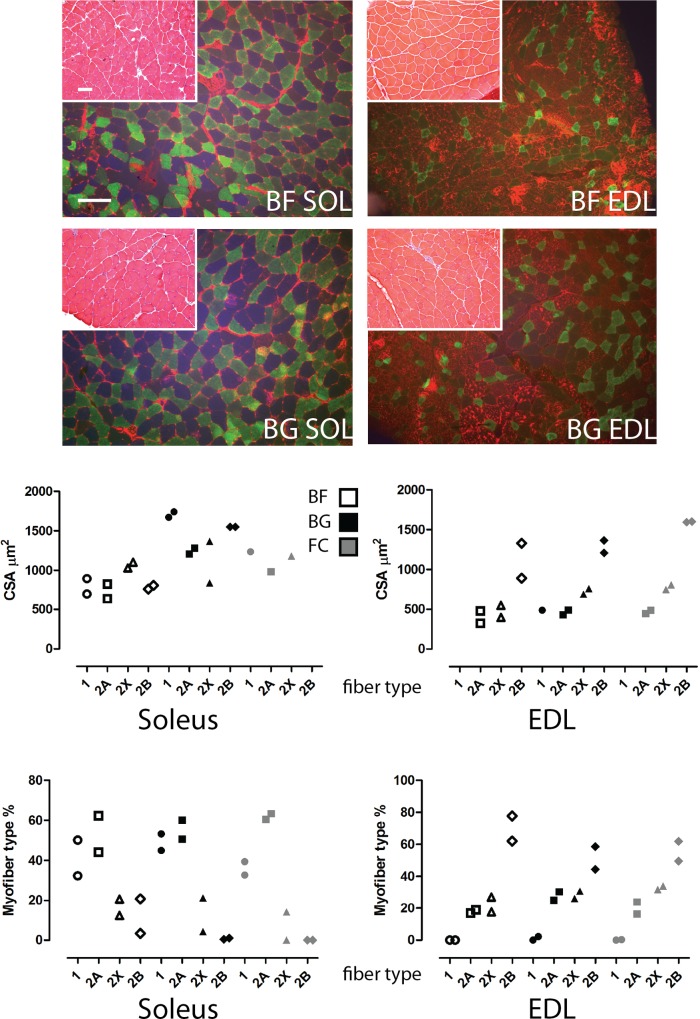
Morphological analysis of mouse soleus and EDL skeletal muscle flown on board the BION-M1 biosatellite for 30 days.Upper panel, insets show light microscopy images of Haematoxylin Eosin merged to immunofluorescence images of soleus (SOL) and EDL stained for MyHC isoforms (MyHC I: blue, IIa: green, IIb: red) in flown (BF) and control (BG) mice. Lower panel, scatter plots showing the quantification of the myofiber cross sectional area (CSA) and type composition in soleus (n = 2) and EDL (n = 2). Scale bar: 100 μm.